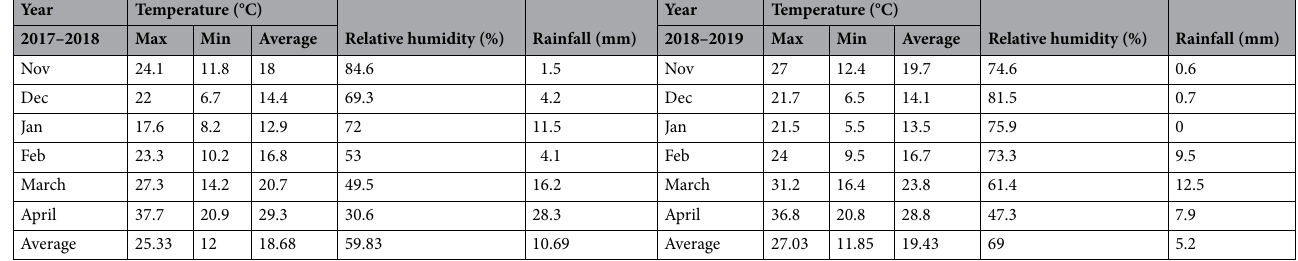
Table 1. Weather data during the field trial of 2017 and 2018 at the experimental